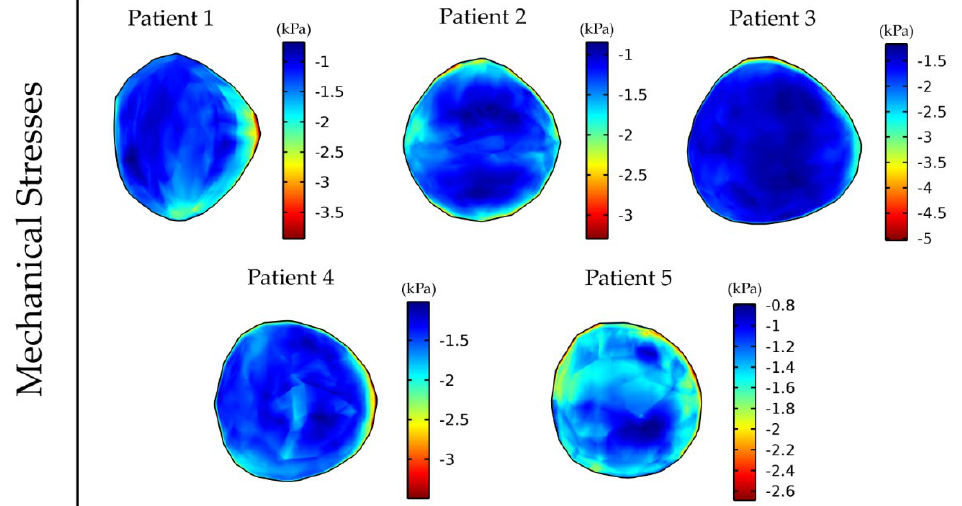
Figure 4. Distribution of intratumor mechanical stress at day 43 of the simulation for anisotropic tumor growth (A = 25). For the tumor region, the corresponding patient’s elastography data were used, and elastography data for a healthy subject were used for the rest of the brain. The bulk stress (trace of the stress tensor) is presented, and the negative sign denotes tissue compression.